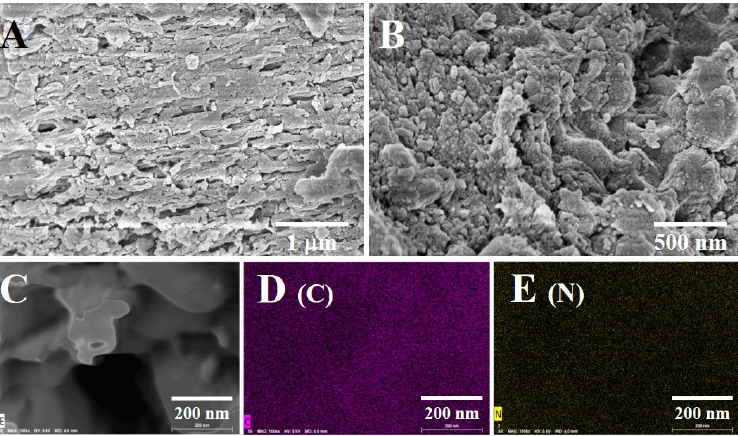
Figure 1. SEM images ( A , B ) and the corresponding EDS elemental mapping images ( C – E ) of g-CN.